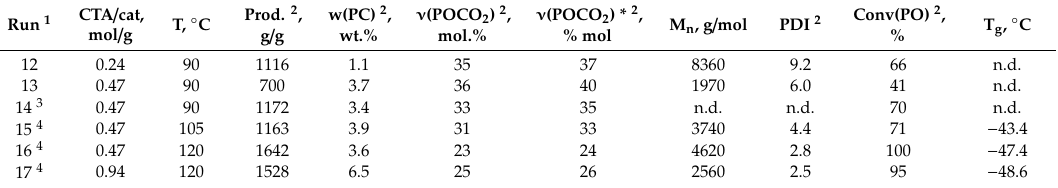
Table 4. Results of CO 2 / PO copolymerization in the presence of 1,6-hexanediol